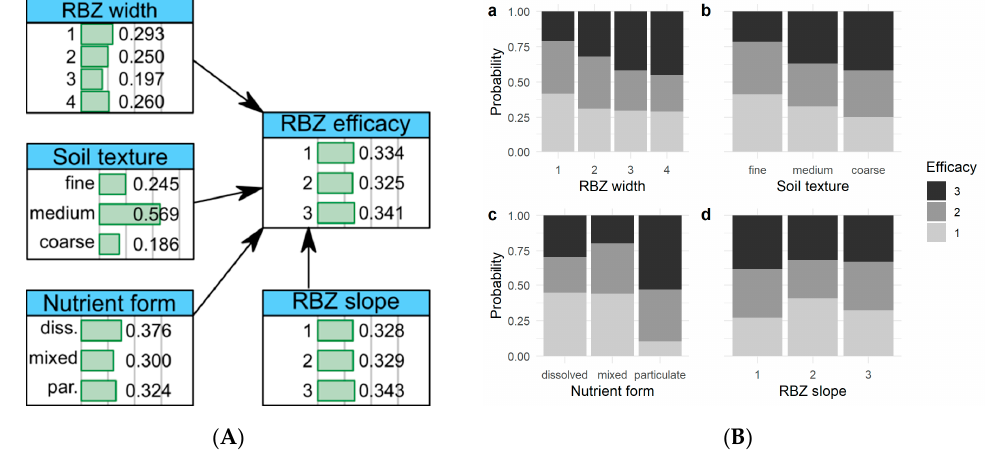
Figure 8. The “optimal” BN with three output states ( A ) influence diagram (Supplementary File S2, par. = particulate, diss. = dissolved), ( B ) probability of the output states (RBZ efficacy) given hard evidence of the parent node mentioned below the subfigures a–d (state with probability = 1 on x axes) and soft evidence (here equal probability of all states) of the other parent nodes. Higher state numbers correspond to broader RBZ (RBZ width), steeper RBZ (RBZ slope), and more efficient RBZ.